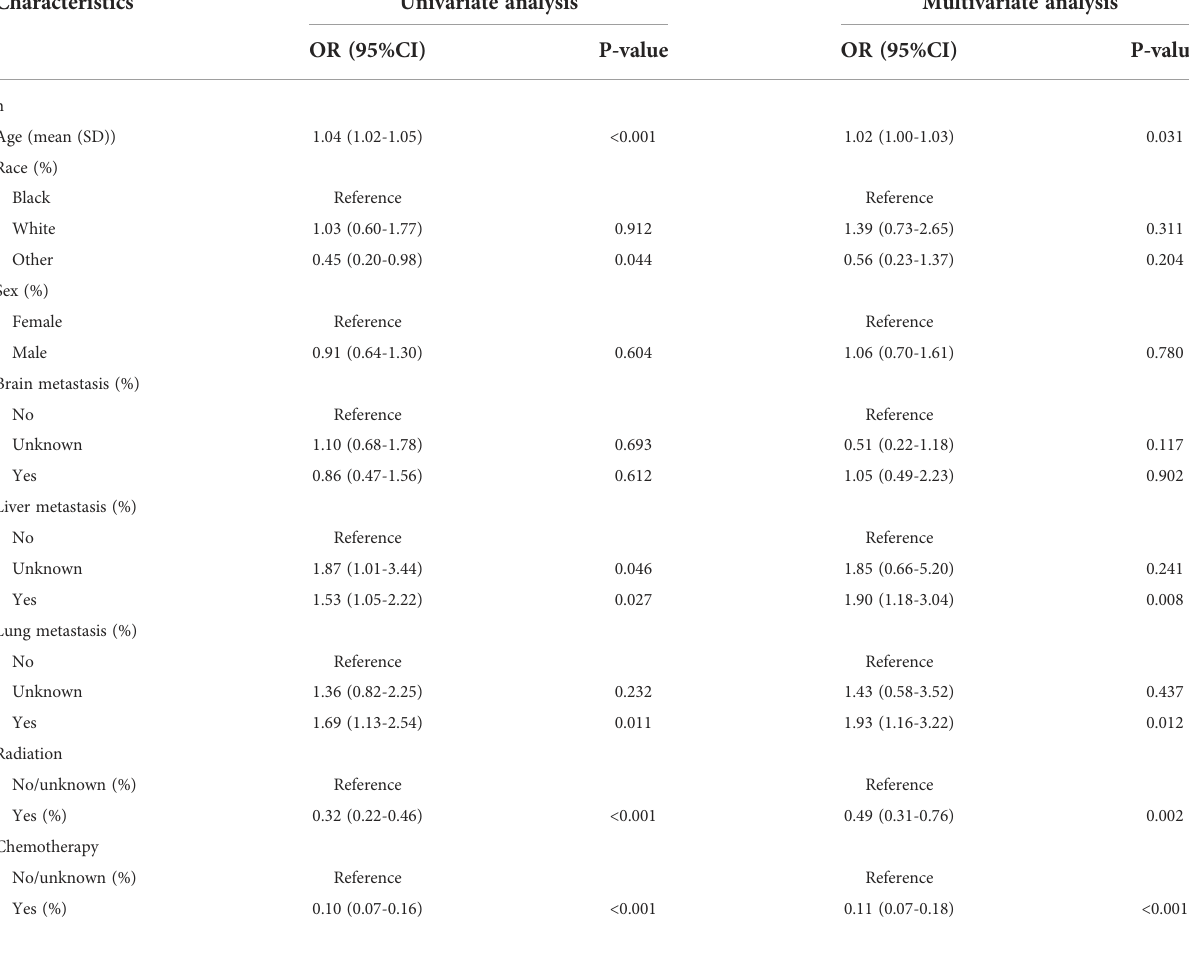
TABLE 3 Univariate and multivariate analysis of potential risk factors for predicting three-month mortality among bone metastasis from CUP in the training cohort.